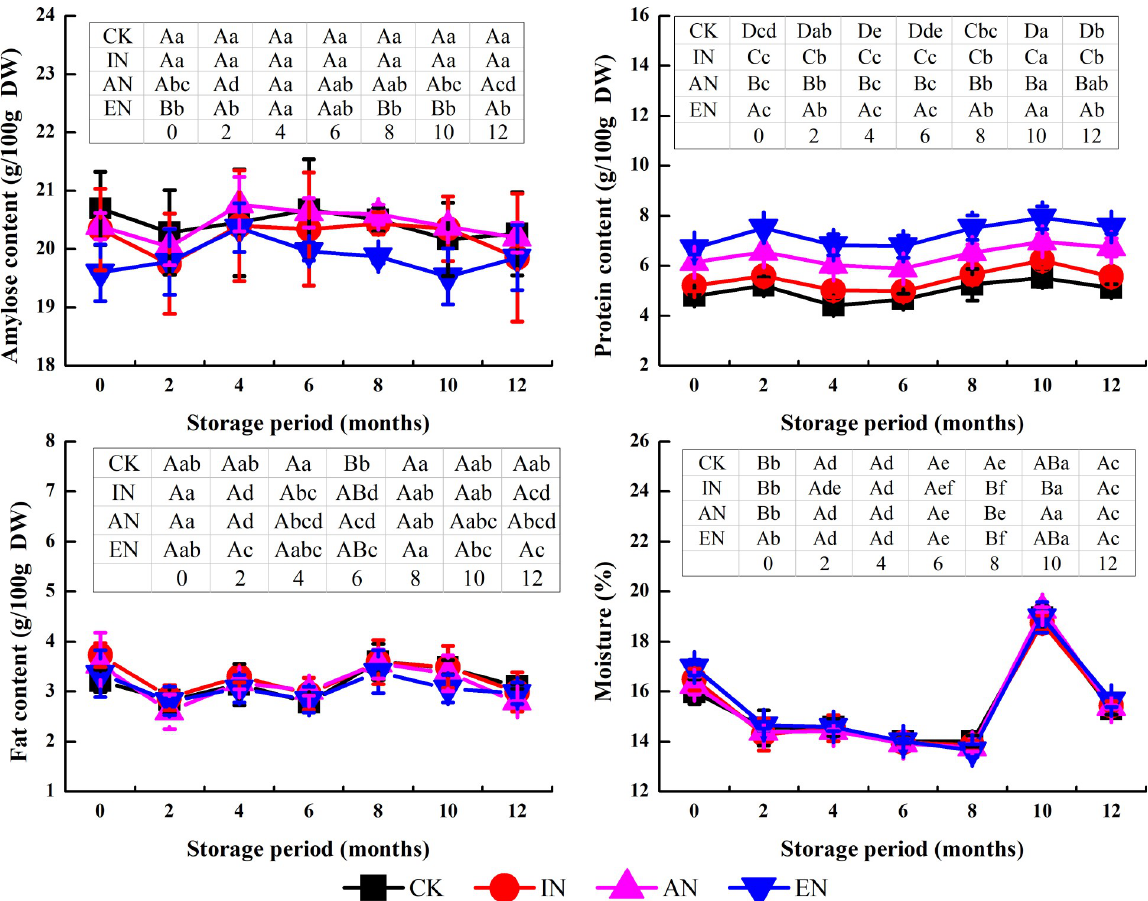
Fig 3. The changes in the content of chemical components in rice under storage, following the different nitrogen application rates. CK, control group (0 kg N/ha); IN, insufficient nitrogen (160 kg N/ha); AN, adequate nitrogen (260 kg N/ha); EN, excessive nitrogen (420 kg N/ha). Data (mean ± standard deviation, n = 9) with different letters are significantly different (p < 0.05). For each parameter in the inset table, different lowercase letters in the same rows differ significantly as a function of storage time (Duncan’s test; p < 0.05). Different uppercase letters in the column denote significant differences as a function of nitrogen application rates (p <